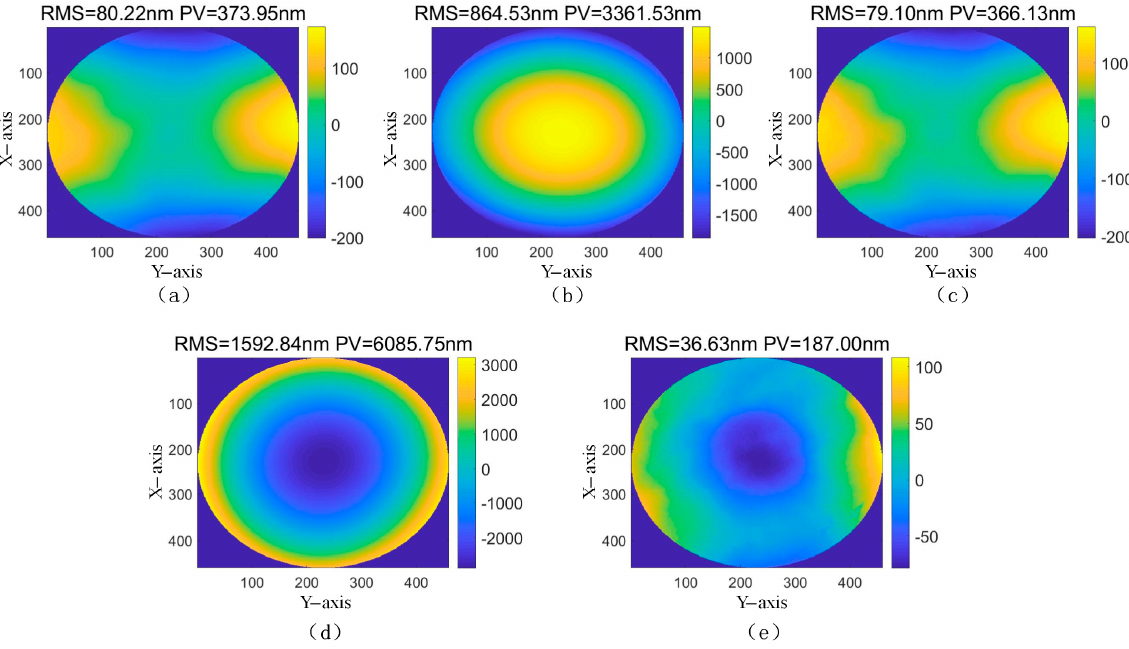
Figure 9. Experiment results of the optical planar element (after removing the first three terms): ( a ) EPCM; ( b ) PM with systematic errors; ( c ) PM after eliminating systematic errors; ( d ) MPMD; ( e ) Interferometer.